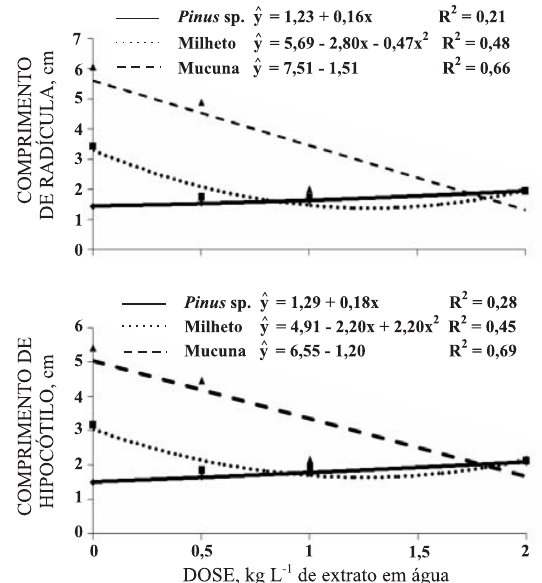
Figura 1. Comprimento de radícula e de hipocótilo de soja em função da aplicação de quatro doses de extrato aquoso de Pinus , milheto e mucuna, em condições de germinador, por sete dias a 25 °C; médias de quatro